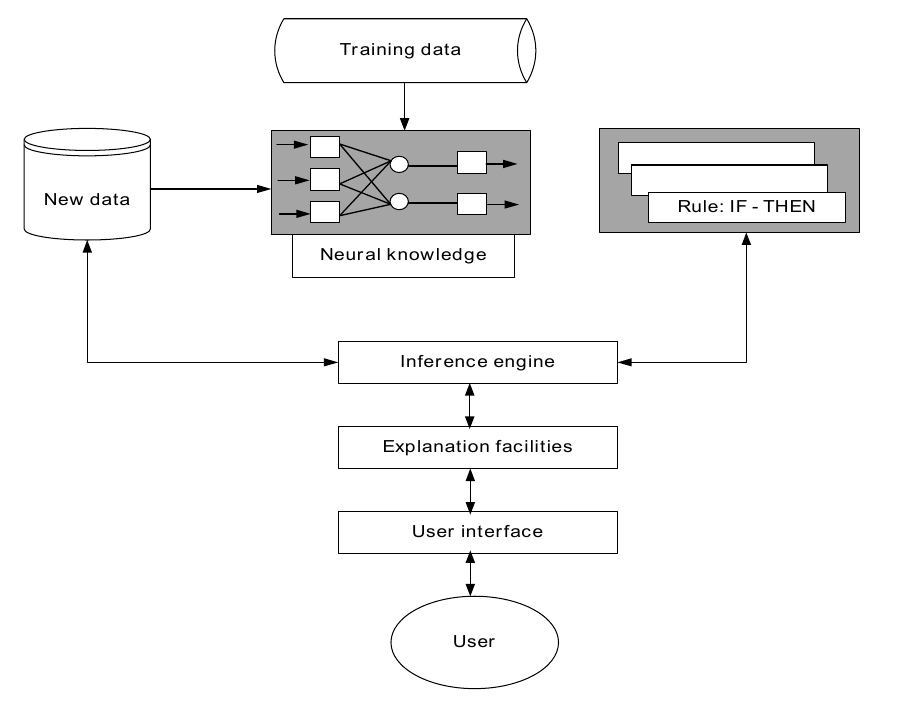
Figure 6. Basic structure of a neural expert system.